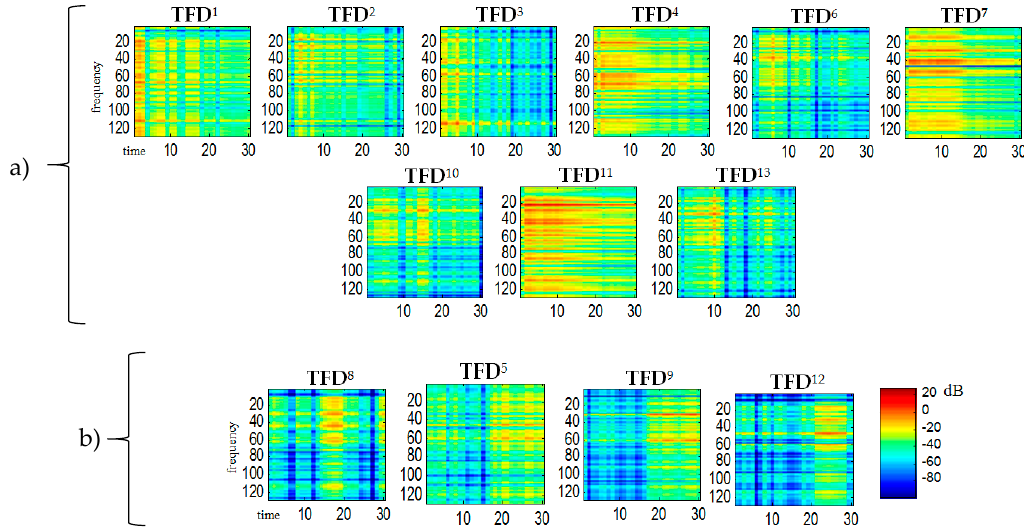
Figure 4. 7 time bases 𝑡 (cid:3036) obtained by ICA on the spectrogram of the mixed signal for variance α = 0.85 .